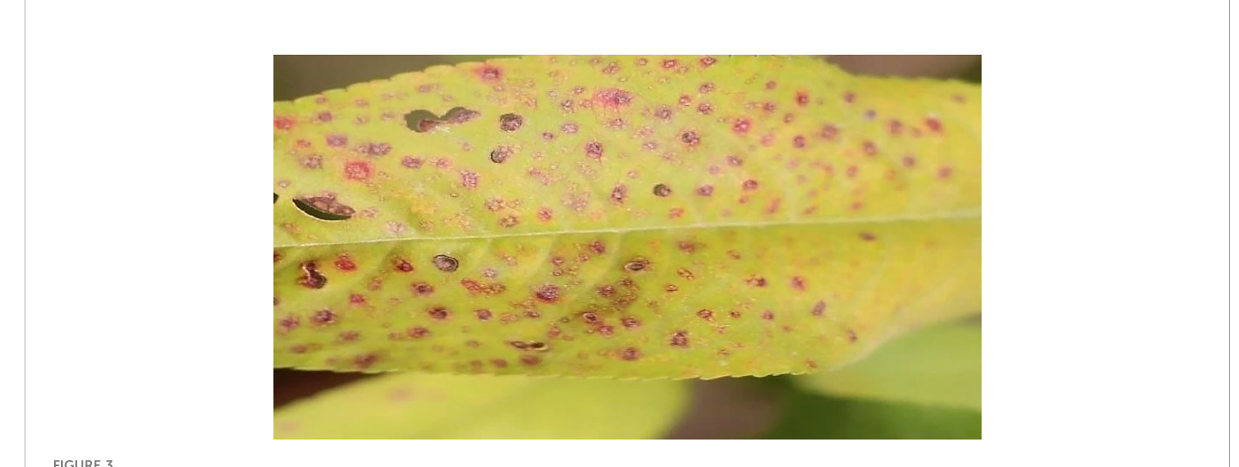
FIGURE 3 Bacterial spot of the peach leaf.